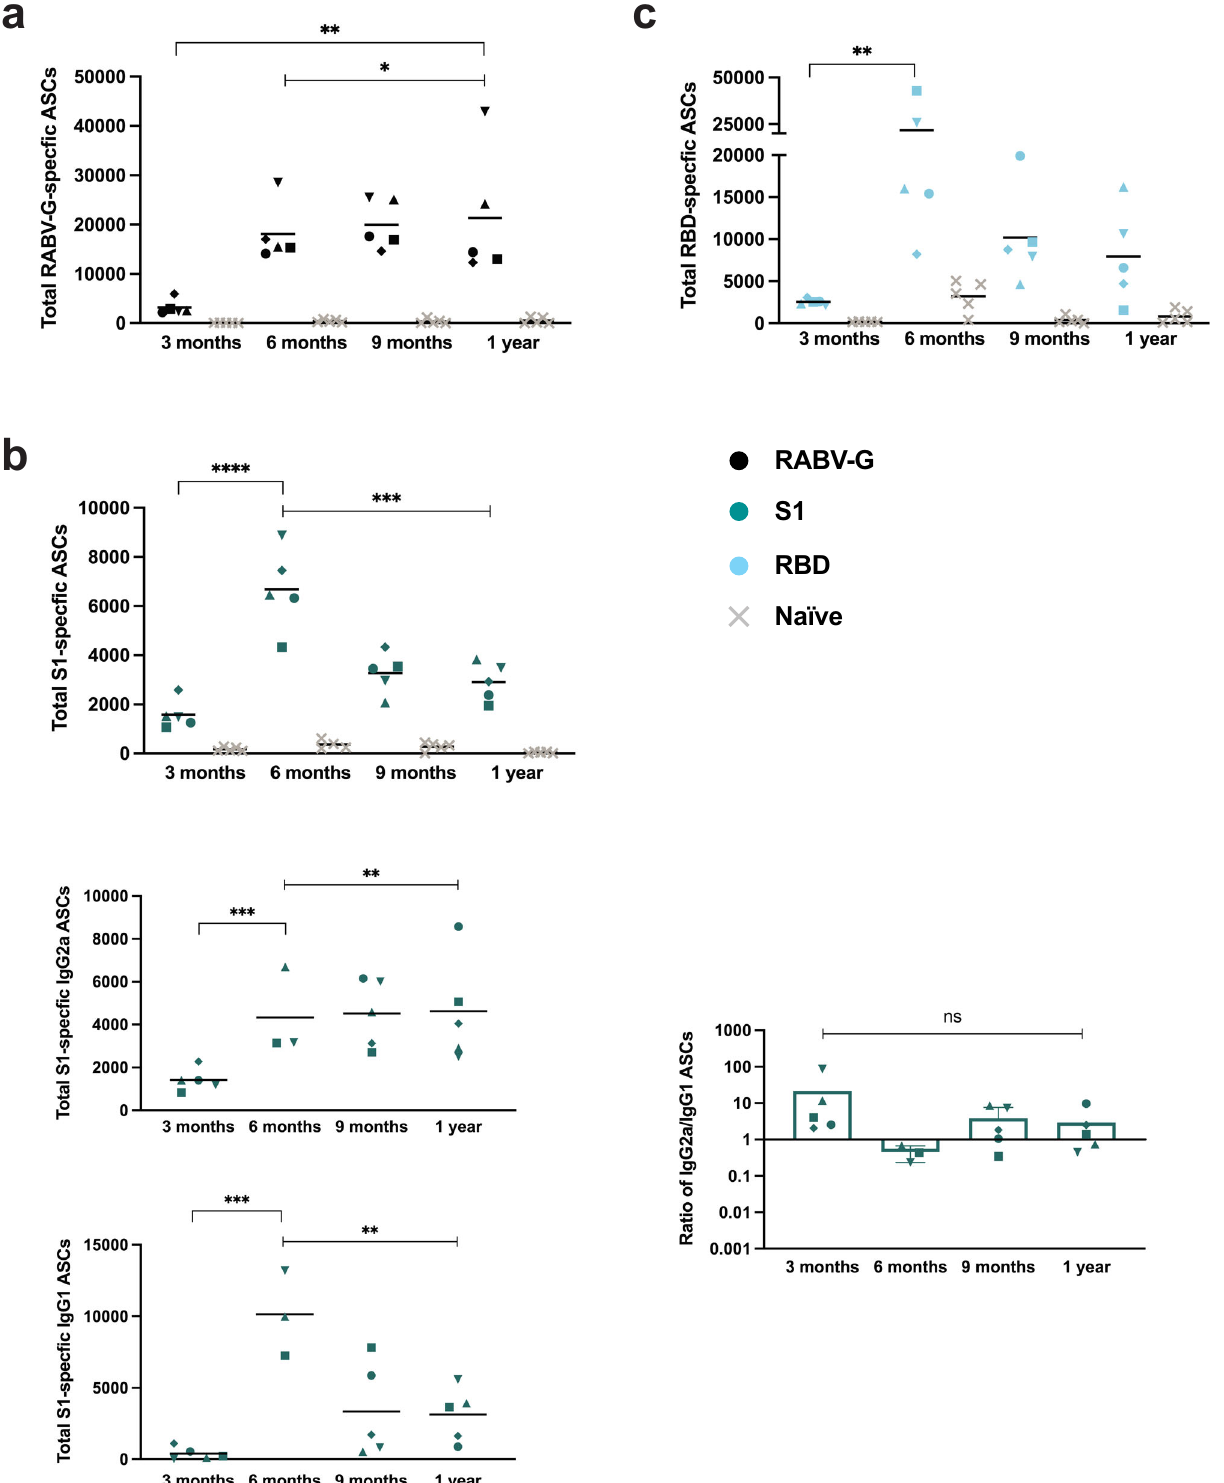
Fig. 6 Long-term responses to CORAVAX are maintained by long-lived antibody-secreting cells (ASCs) in the bone marrow. a The average total number (line) of RABV-G b S1 and c RBD-speci fi c ASCs present in individual mouse bone marrow (symbols) at 3 months, 6 months, 9 months, and 1 year compared to naive controls (gray × symbols). The line represents the average per group. b Additionally for S1, average total number of IgG2a and IgG1 ASCs (lines) from individual mice (symbols) and ratio of IgG2a/IgG1 ASCs. Statistics are by one-way ANOVA with post-hoc Tukey ’ s test of the log-transformed total number of cells or ratios. p > 0.1234 (ns), p < 0.0332 (*), p < 0.0021 (**), p < 0.0002 (***), p < 0.0001